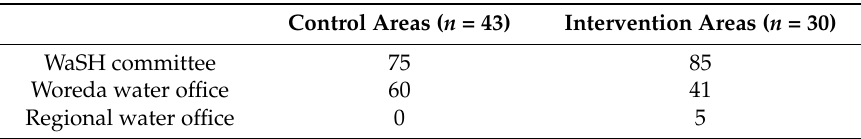
Table 6. Responsibility of maintenance and repair of pump.